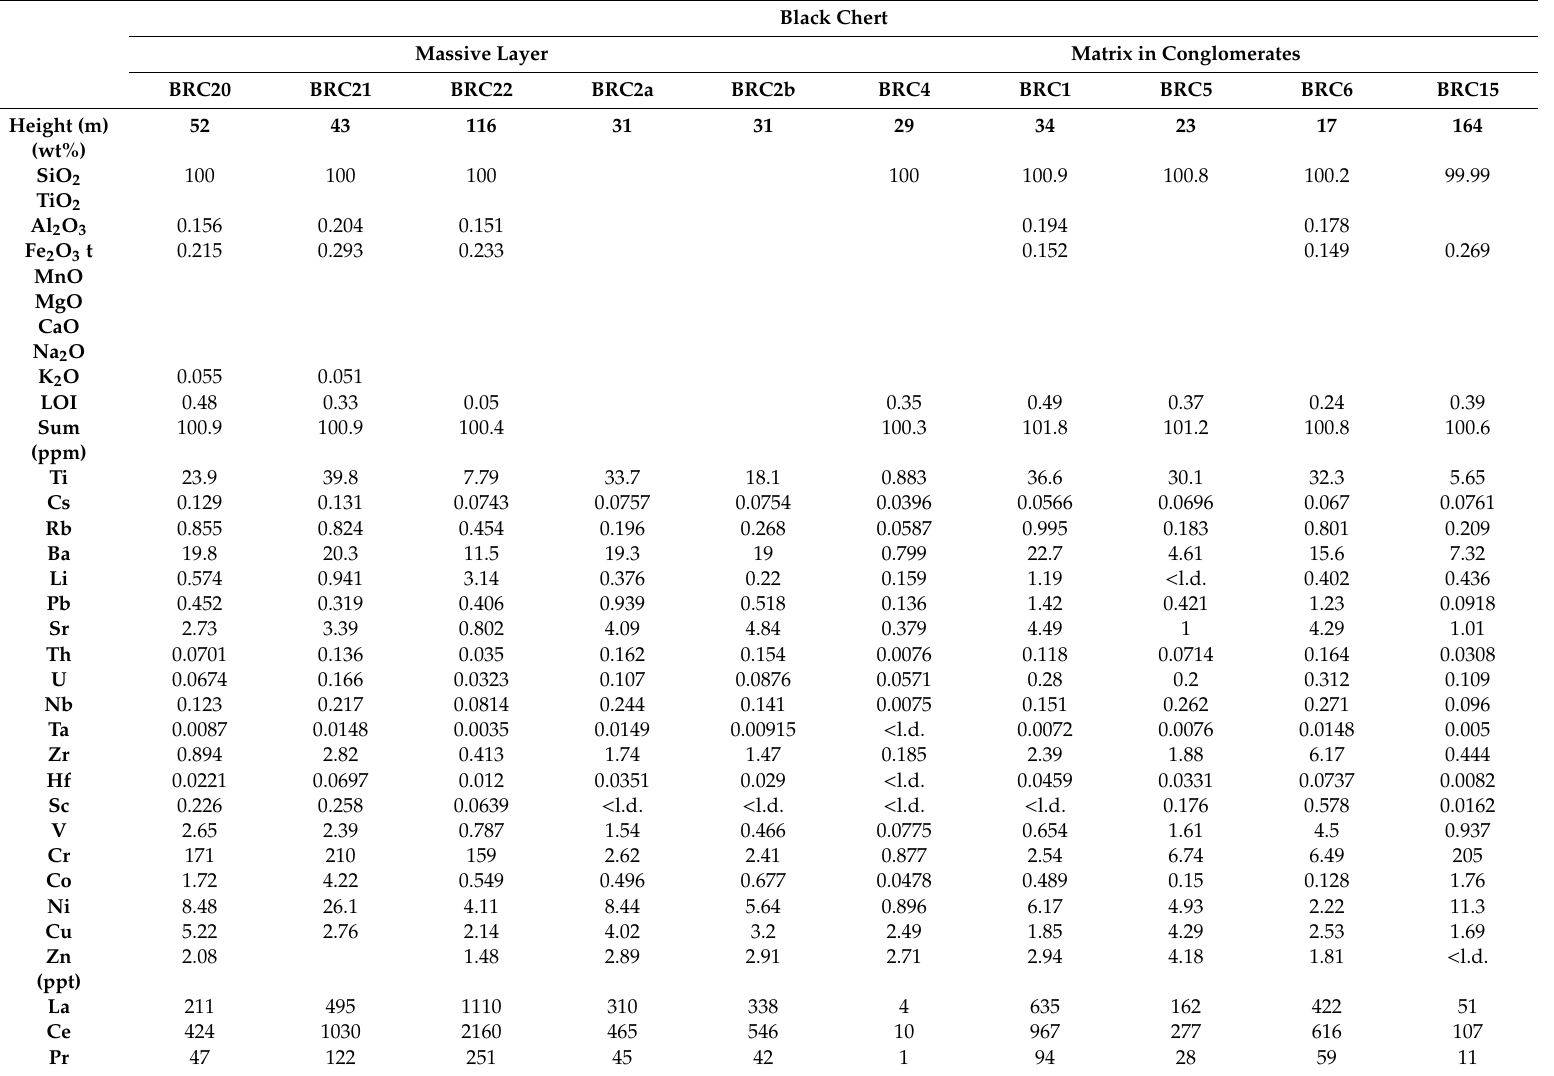
Table 2. Representative analyses of major and trace